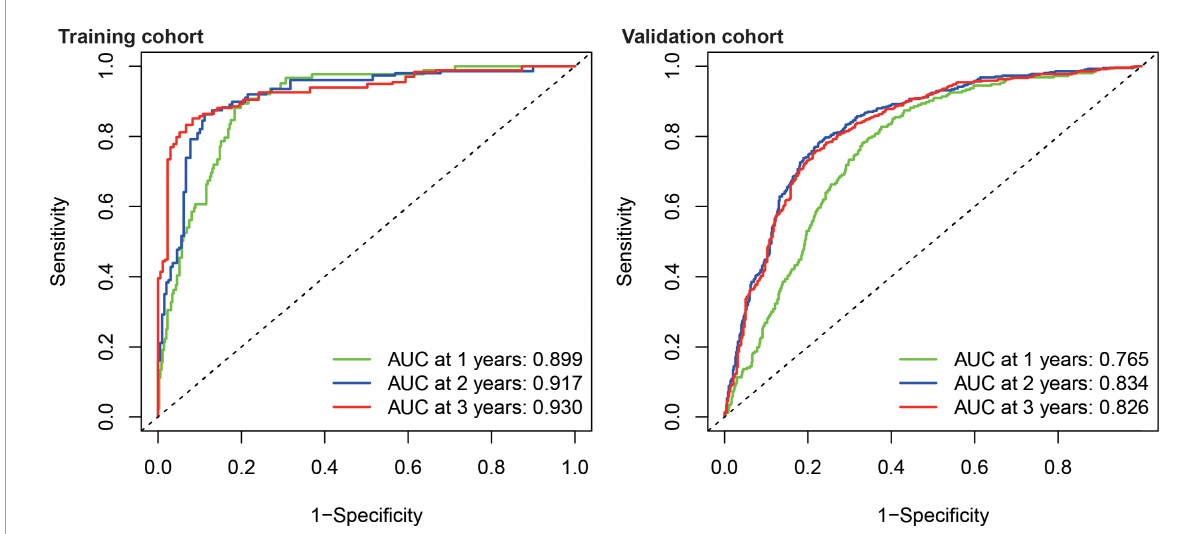
FIGURE7 Time-dependent receiver operating characteristic analysis showed the AUC of FRGs for 1, 2, and 3 years in the training and validation cohort.